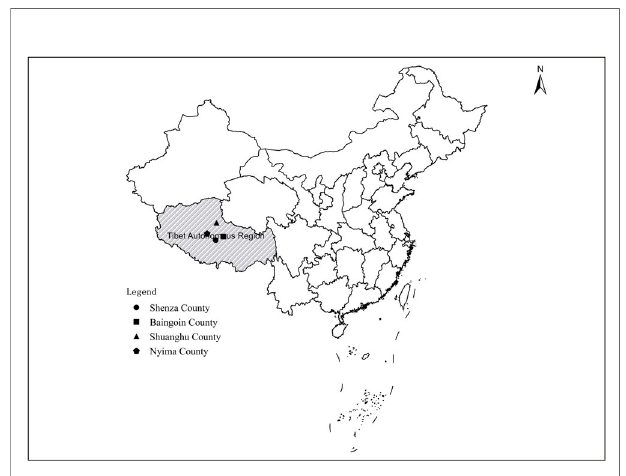
FIGURE 1 | A map of Tibet Autonomous Region, China showing the geographical regions in Nyima County, Shuanghu County, Shenza County, and Baingoin County, in which Tibetan Antelope were